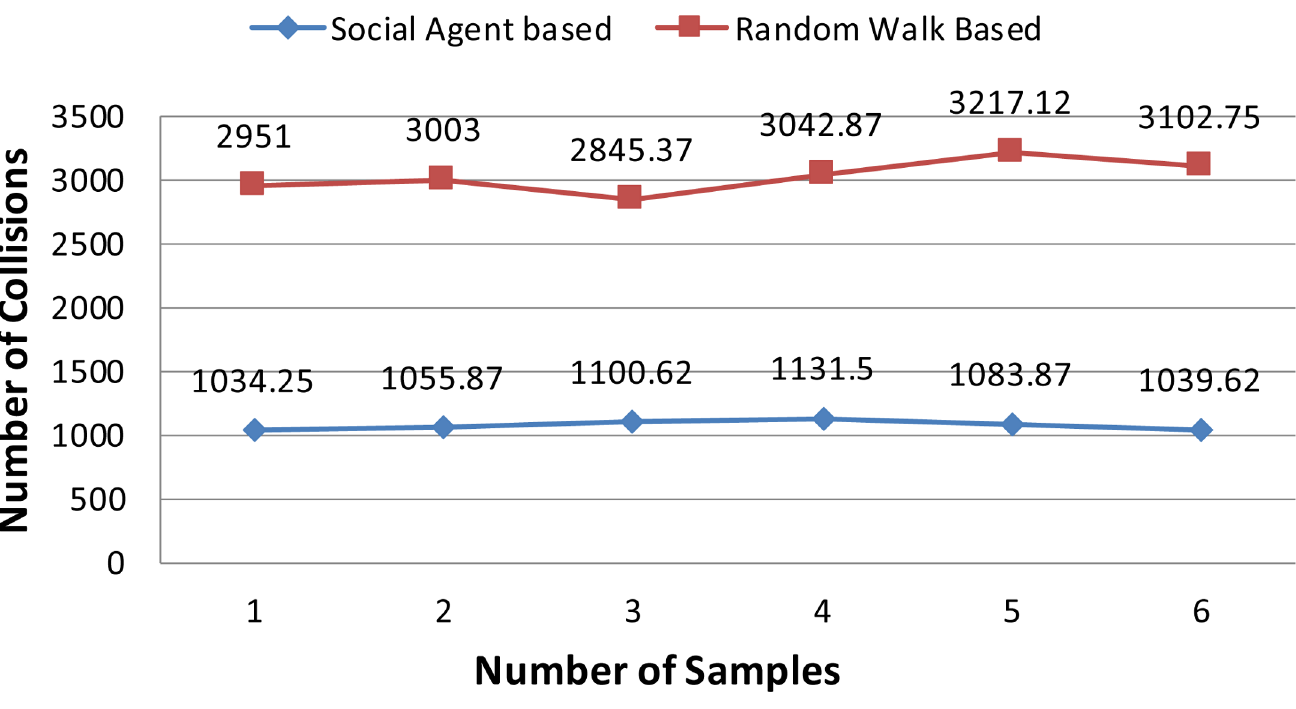
Fig 8. Graphical representation of test case 5.